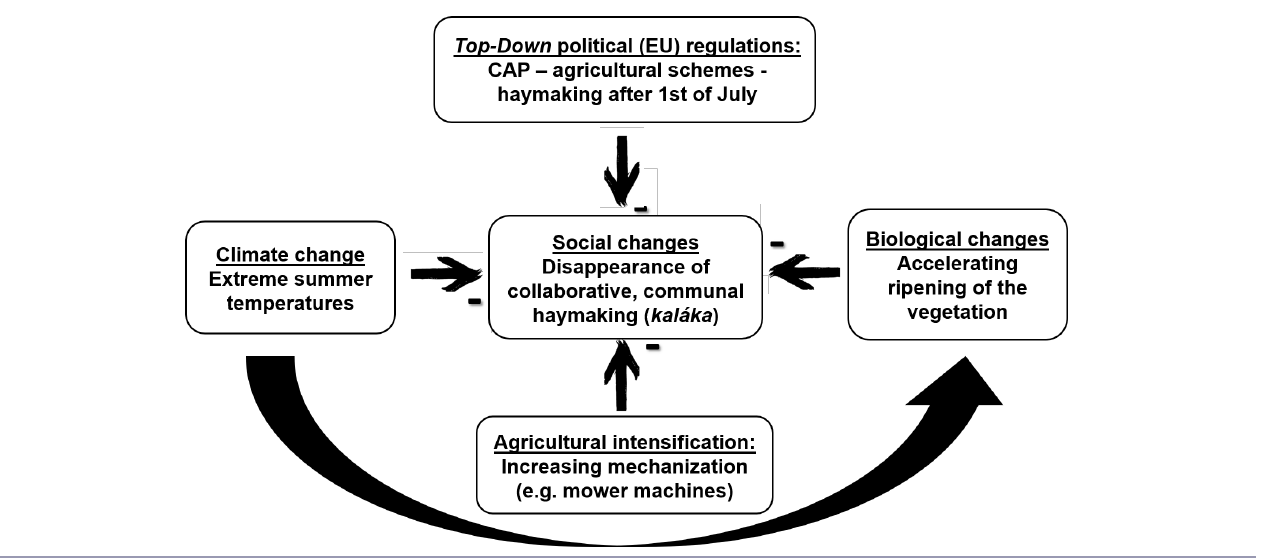
Fig. 8 . The indirect and direct drivers that caused the practice of “collaborative,